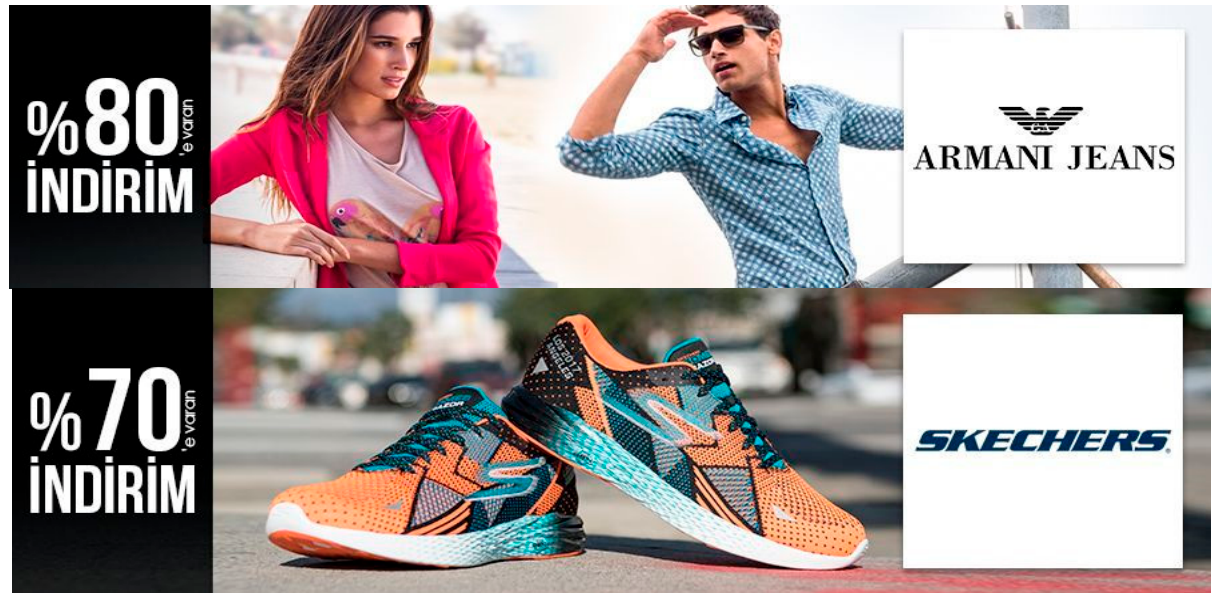
Figure A1. The banner ads numbered 1a ( above ) and 1b ( below ).